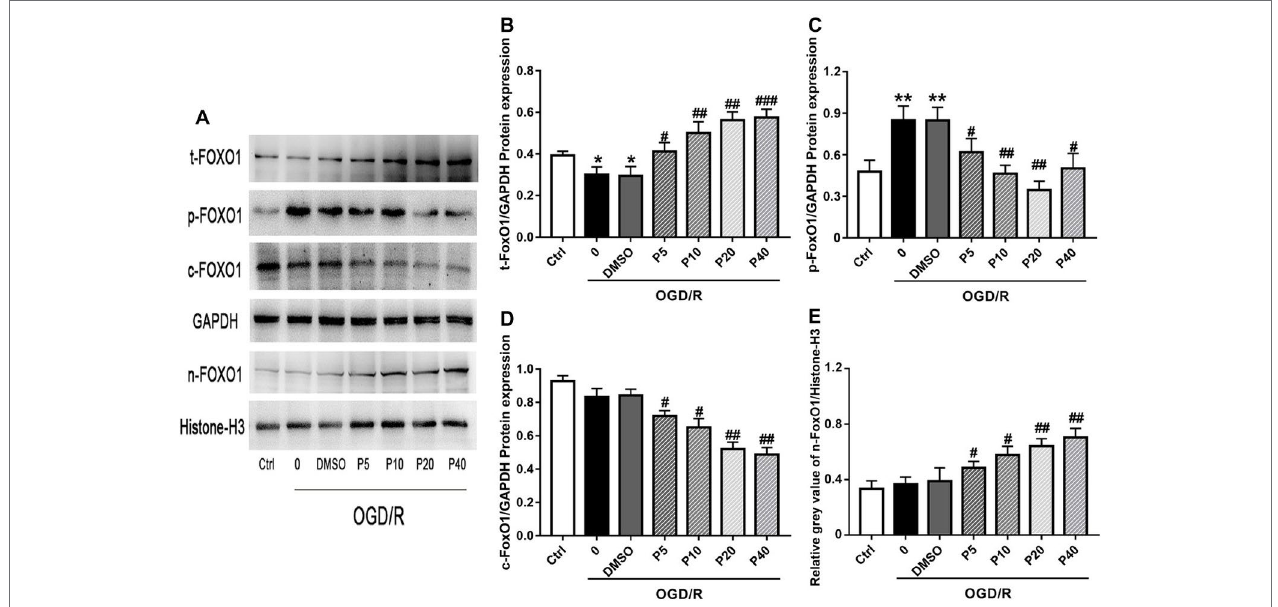
FIGURE 4 | Propofol inhibited FoxO1 phosphorylation and promoted FoxO1 shuttling into the nucleus in H9c2 cells during OGD/R insult. Representative bands of (A) t-FoxO1, p-FoxO1, c-FoxO1, and n-FoxO1. Relative gray value/GAPDH of (B) t-FoxO1, (C) p-FoxO1, (D) c-FoxO1, (E) n-FoxO1. The data are presented as the mean ± SD of three independent experiments. * p < 0.05, ** p < 0.01, *** p < 0.001 versus control, # p < 0.05, ## p < 0.01, ### p < 0.001 versus OGD/R treated group without